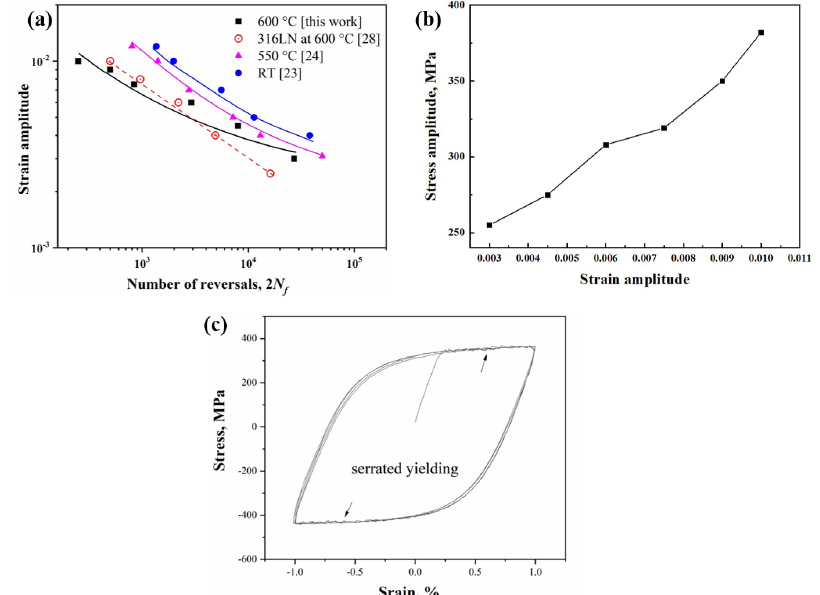
Figure 2. (a) Fatigue life, (b) cyclic stress amplitudes with total strain amplitudes, (c) serrated yielding in the hysteresis